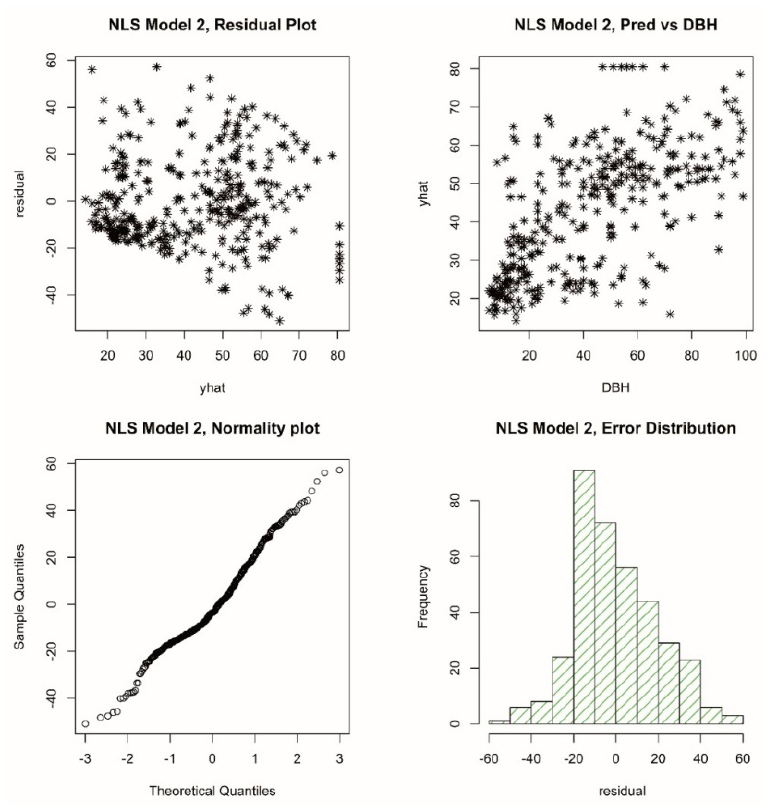
Figure A2. Diagnostic plot for the nls model.